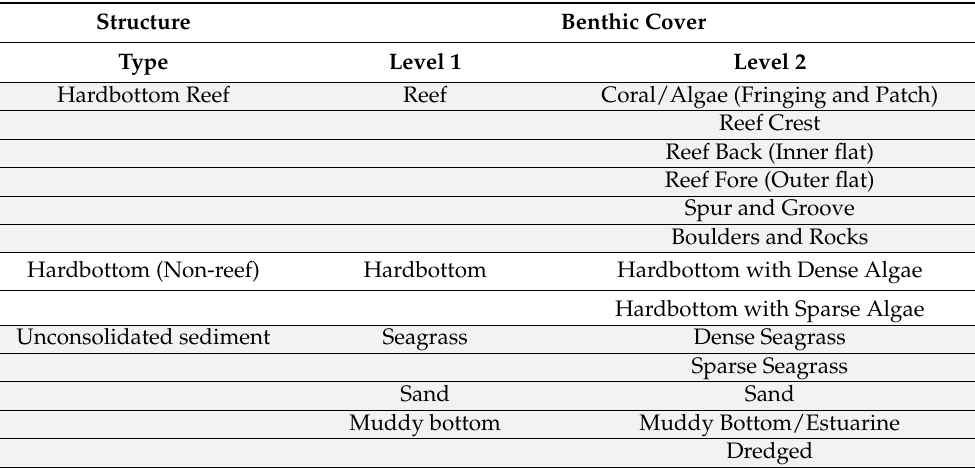
Table 2. Final thirteen-class benthic habitat classification scheme selected for use in the Caribbean- wide mapping. Classifications and accuracy assessments were performed on both Level 1 and 2.